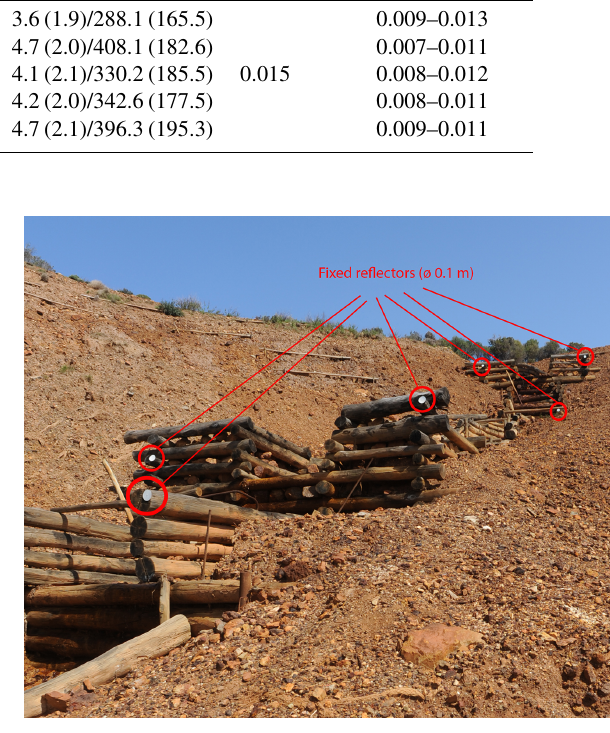
Figure 3. Picture of the mounted tie points on the debris flow bar-